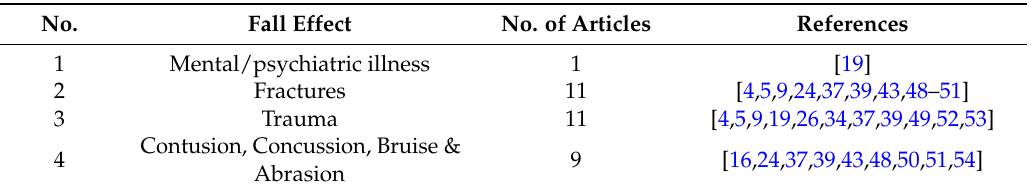
Table 9. Most common FFH